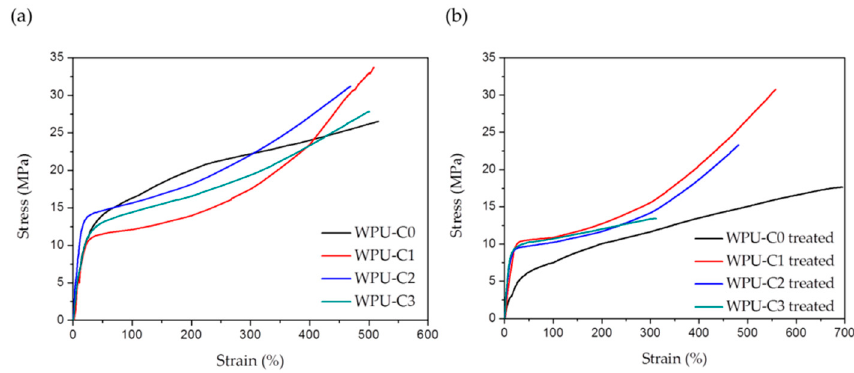
Figure 5. The strain-stress curves for different WPUs: ( a ) samples before heat treatment; ( b ) samples after heat treatment for 24 h at 110 ° С .